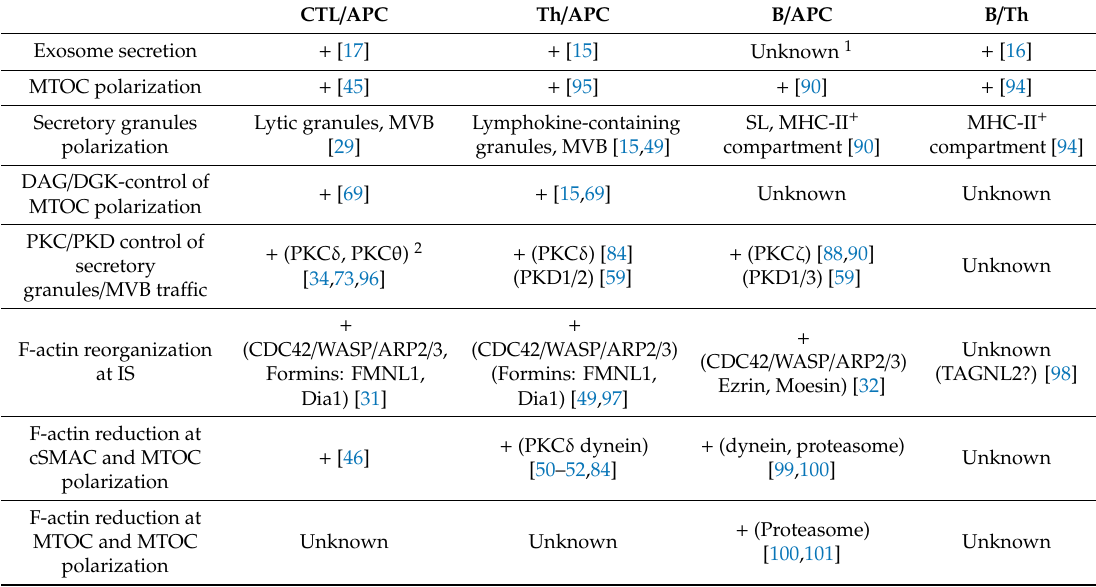
Table 1. Di ff erent IS and polarized secretory tra ffi c in T lymphocyte IS and B lymphocyte